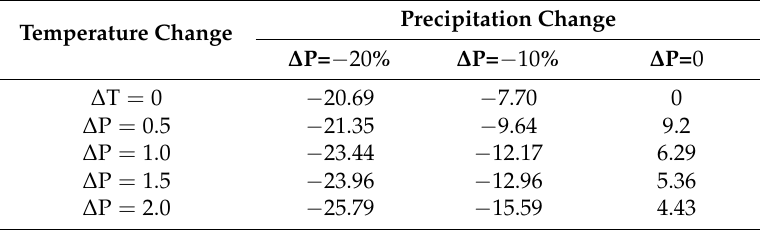
Table 12. Response of runoff to temperature increase and precipitation decrease.